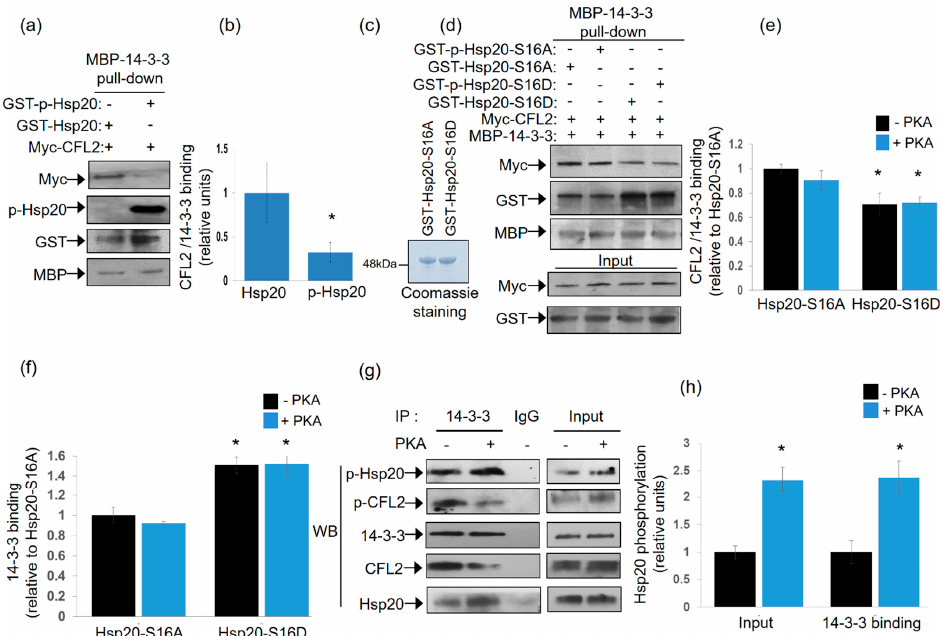
Figure3. PhosphorylatedHsp20displacesCFL2from14-3-3proteincomplex. ( a )Pulldownassaysusing MBP-14-3-3 recombinant protein and lysates from HEK 293 cell transfected with myc-CFL2. Binding of CFL2 to 14-3-3 was examined in the presence of GST-Hsp20 or Ser16-phosphorylated GST-Hsp20. ( b ) Quantification of CFL2 / 14-3-3 binding in the presence of GST-Hsp20 or Ser16-phosphorylated GST-Hsp20 (* p < 0.05, t test, two-tailed; n = 3). Data are the mean ± SD. ( c ) Coomassie blue stained gel showing purified recombinant GST-Hsp20-S16A and GST-Hsp20-S16D recombinant proteins. ( d ) Pull down assays using MBP-14-3-3 recombinant protein and lysates from HEK 293 cell transfected with myc-CFL2. Binding of CFL2 to 14-3-3 was examined in the presence of GST-Hsp20-S16A, GST-Hsp20-S16D, or phosphorylated GST-Hsp20-S16A and phosphorylated GST-Hsp20-S16D. ( e ) Quantification of CFL2 / 14-3-3 binding in the presence of GST-Hsp20-S16A or GST-Hsp20-S16D (* p < 0.05 vs. Hsp20-S16A -PKA, t test, two-tailed; n = 3). Data are the mean ± SD. ( f ) Quantification of 14-3-3 binding to GST-Hsp20-S16A or GST-Hsp20-S16D (* p < 0.05 vs. Hsp20-S16A-PKA, t test, two-tailed; n = 3). Data are the mean ± SD. ( g ) Immunoprecipitation assays in PKA-phosphorylated or non-phosphorylated cardiac extracts confirmed the enhanced binding of Ser-16 phosphorylated Hsp20 to 14-3-3, along with associated reduction in the phosphorylated CFL2 / 14-3-3 interaction. ( h ) Quantification of the impact of PKA treatment on the levels of Hsp20 phosphorylation in cardiac extracts (input) and 14-3-3 interaction (* p < 0.05, t test, two-tailed; n = 3). Data are the mean ±